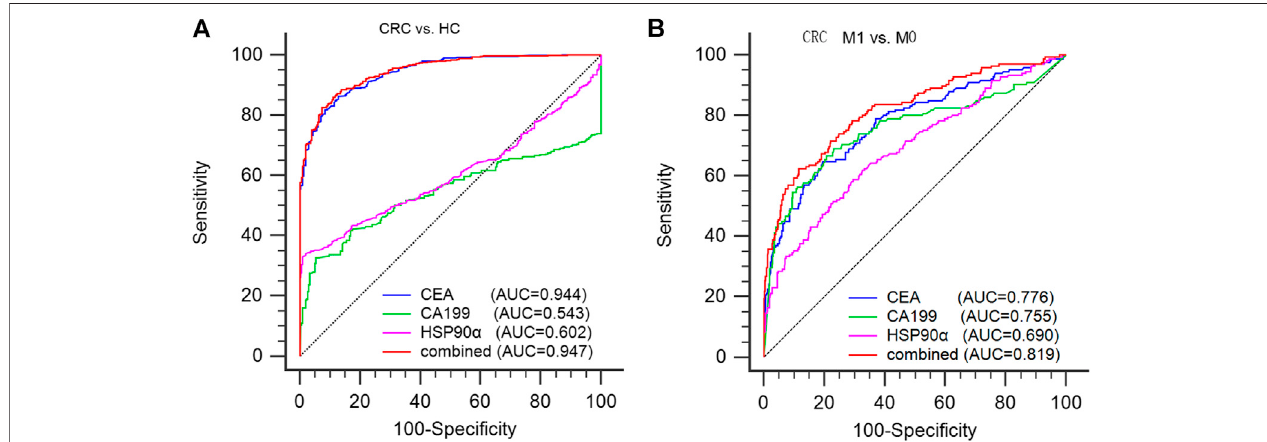
FIGURE3| diagnostic abilityofserum CEA,CA199and plasmaHSP90 α incolorectal cancer. (A) Usinghealthydonorsascontrolstoevaluatetheef fi cacyofCEA, CA199,HSP90 α andthepanelinthediagnosisofcolorectalcancer; (B) UsingM0patientsascontrolstoevaluatetheef fi cacyofCEA,CA199,HSP90 α andthepanelfor distinguishing the presence of distant metastasis from CRC patients. M0: no distant metastasis; M1: distant metastasis.